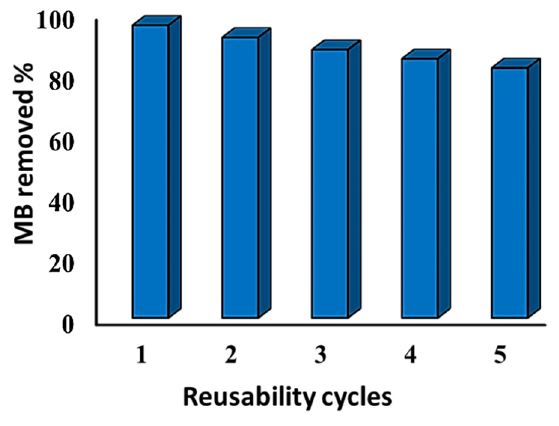
Figure 10. Percentage of MB uptake during the adsorption/desorption cycles.